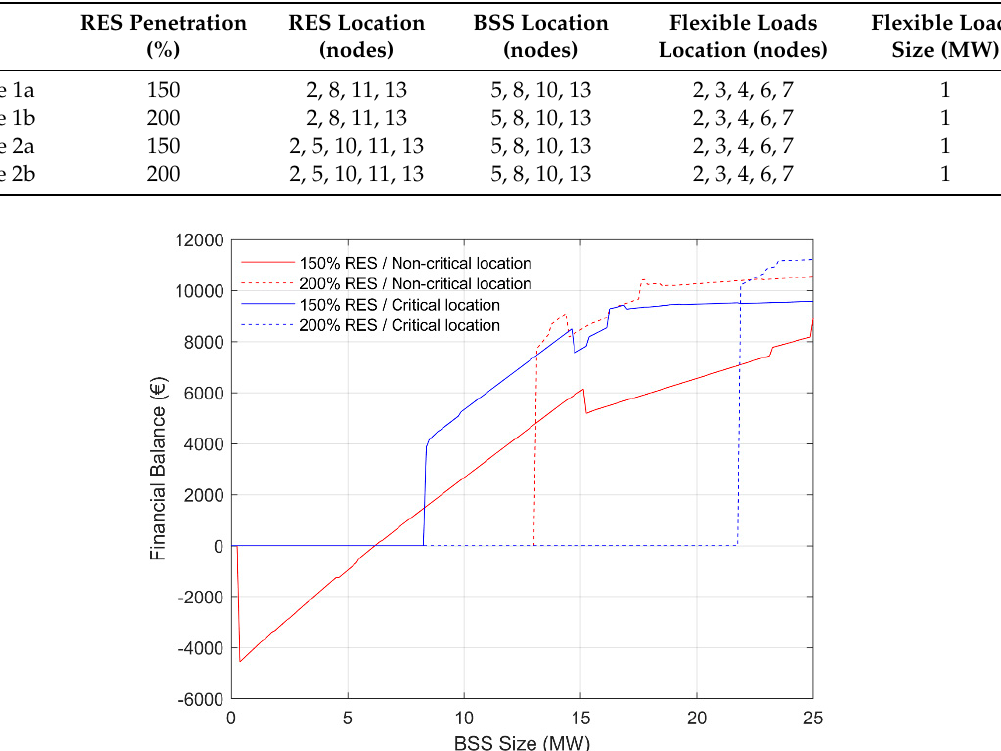
Figure 2. Microgrid Operator (MGO)’s financial balance as a function of Battery Storage System (BSS) size for critical and non-critical Distribution Network (DN) location cases under two RES penetration subcases.